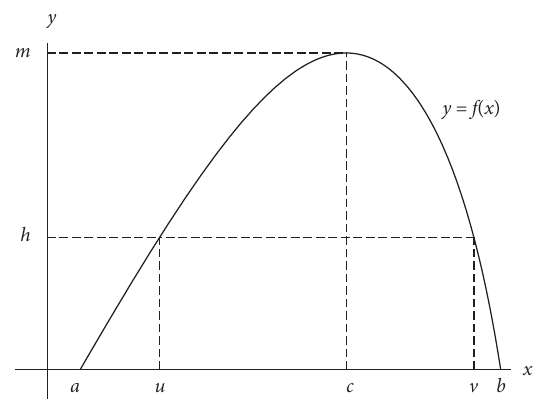
Figure 2: A strictly concave function with strictly concave arbitrary points u and v for which a ≤ u < c < v ≤ b and f ( u ) �